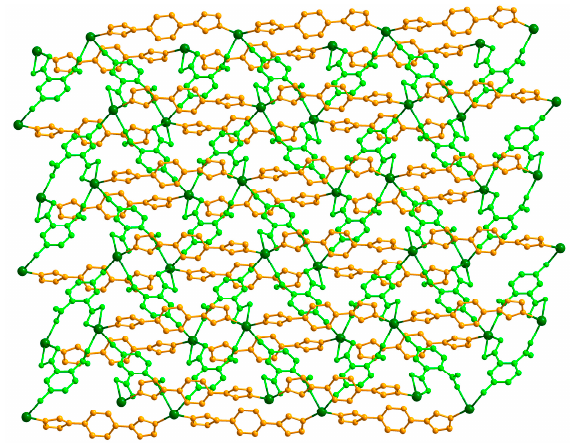
Figure 2. A 2D layer structure built from the Cd(II)(nobda) 2 − ( left ) in 1 and schematic representation of 2D network with (4, 4) topology ( right ).